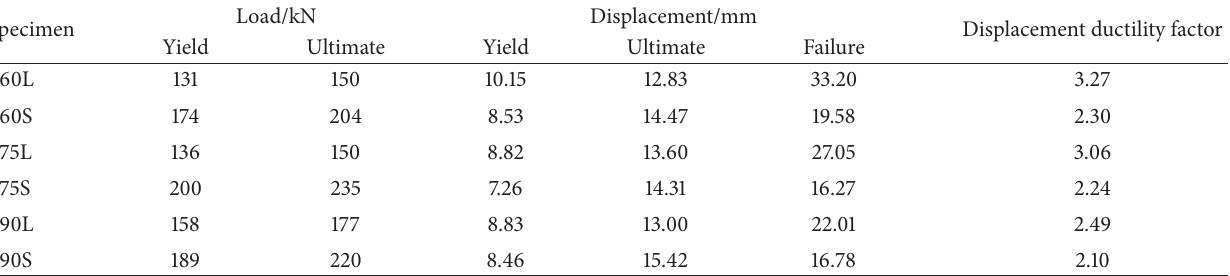
Table 2: Test results of L-shaped